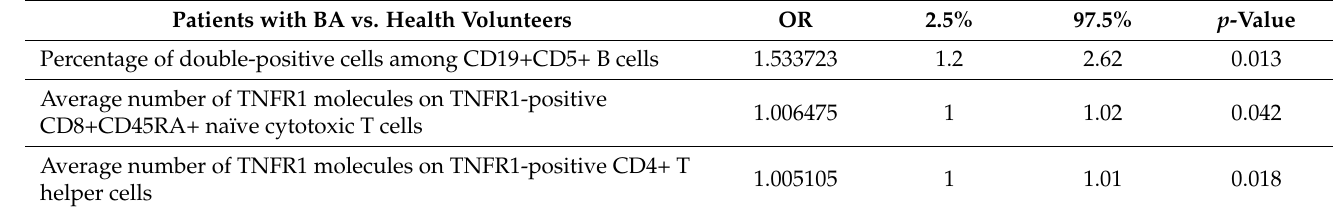
Table 3. Results of multivariate logistic regression analysis.